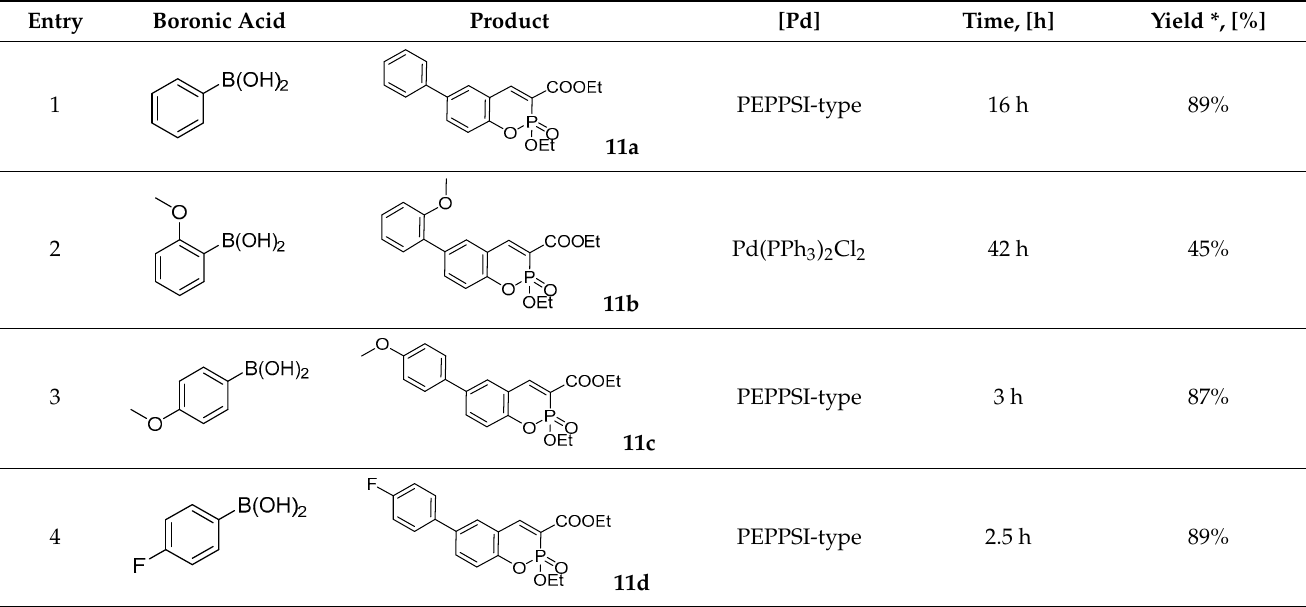
Table 5. Parameters, reagents, and products of palladium-catalyzed arylation of ethyl 6-bromo-2-